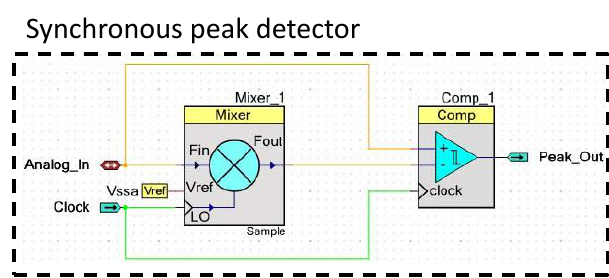
Figure 13. Schematic of the synchronous peak detector. Synchronous peak